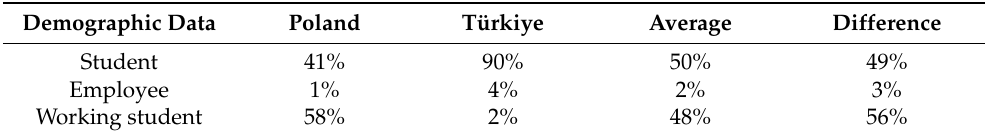
Table 2. Respondents professional